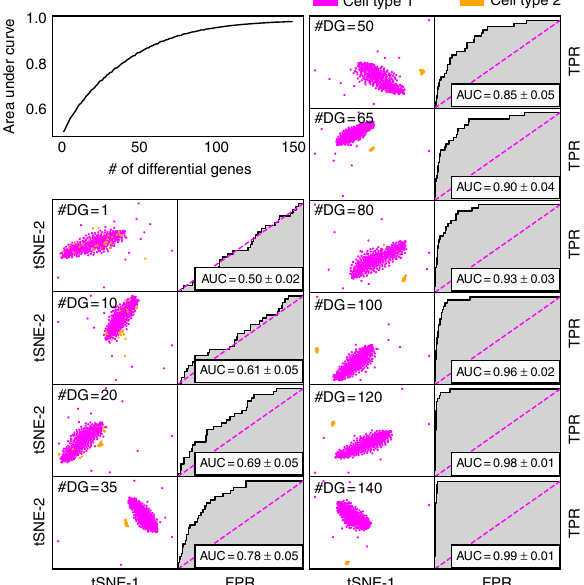
Fig. 4 The sensitivity of FiRE to cell-type identity. On the scRNA-seq data simulated using R package splatter 33 , FiRE starts recognizing the minor cell type correctly, as soon as the number of differentially expressed genes becomes adequate to give rise to a tiny cluster representing the minor cell subpopulation. The top-left corner fi gure serves as a legend for the subsequent AUC-ROC plots. Each t-SNE and ROC plot pair serves as a representative of the 1000 repetitions of the experiment concerning a speci fi c number of differentially expressed genes. The AUC-ROC analysis was performed using cell-type annotations, and FiRE scores were assigned to individual cells We tracked the time taken by LOF, RaceID, GiniClust and FiRE, while varying the input data size (Fig. 5, and Supplementary Table 1), on a single core of a machine with a clock speed of 1.9